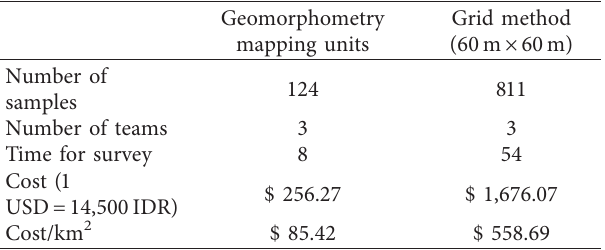
Table 5: Cost comparison between geomorphometry approach and conventional grid method. The grid method calculations are based on a survey in